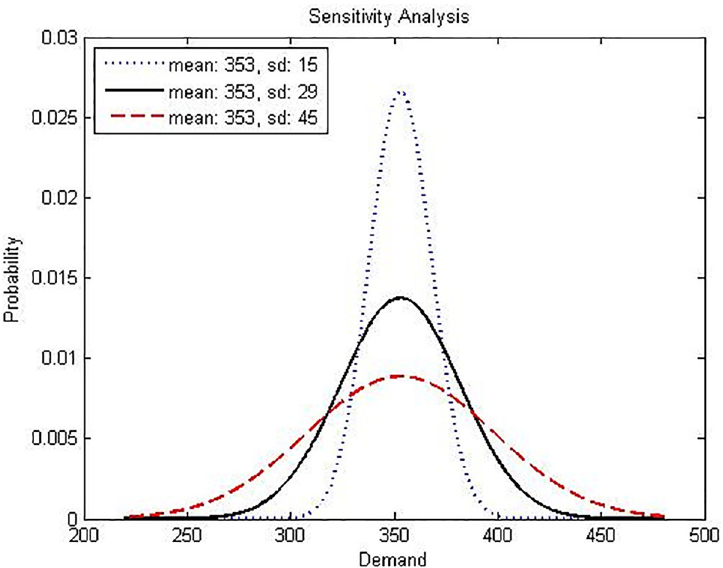
Fig 6. Graphical interpretation of the sensitivity analysis for Model-I varying standard deviation parameter for the random variable demand. Own elaboration.